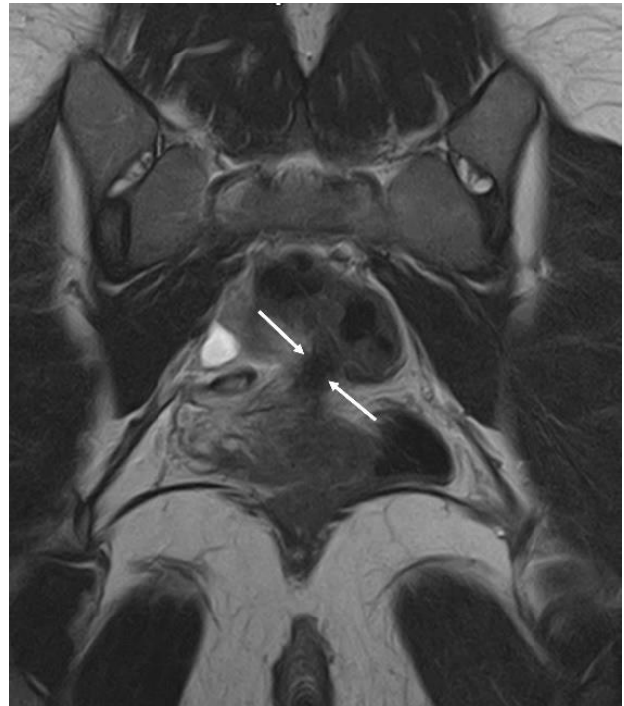
Figure 8. MRI imaging method: a nodule of rectosigmoid colon between the two arrows in the coronal plane.